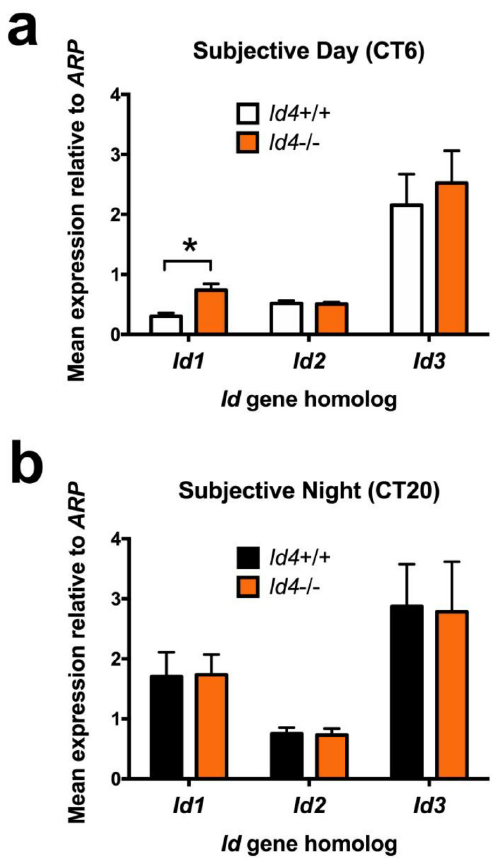
Figure 9. Id4 -null mice exhibit abnormally elevated daytime gene expression of Id1 within the suprachiasmatic nucleus. Quantative gene expression assessment of Id1 , Id2 , and Id3 in wild-type and Id4 − / − mice SCN. Mice were extrained to a 12:12 LD cycle and transferred to DD before time-specific assement. qRT-PCR analysis of time-specific SCN tissue punches, collected at ( a ) Circadian time (CT) 6 (subjective daytime, wild type ( Id4 +/+) n = 8, Id4 − / − n = 7) and ( b ) CT20 (subjective night, wild type n = 10, Id4 − / − n = 12). Values are mean ± SEM relative gene expression values (relative to acidic ribosomal protein , ARP expression). * p <